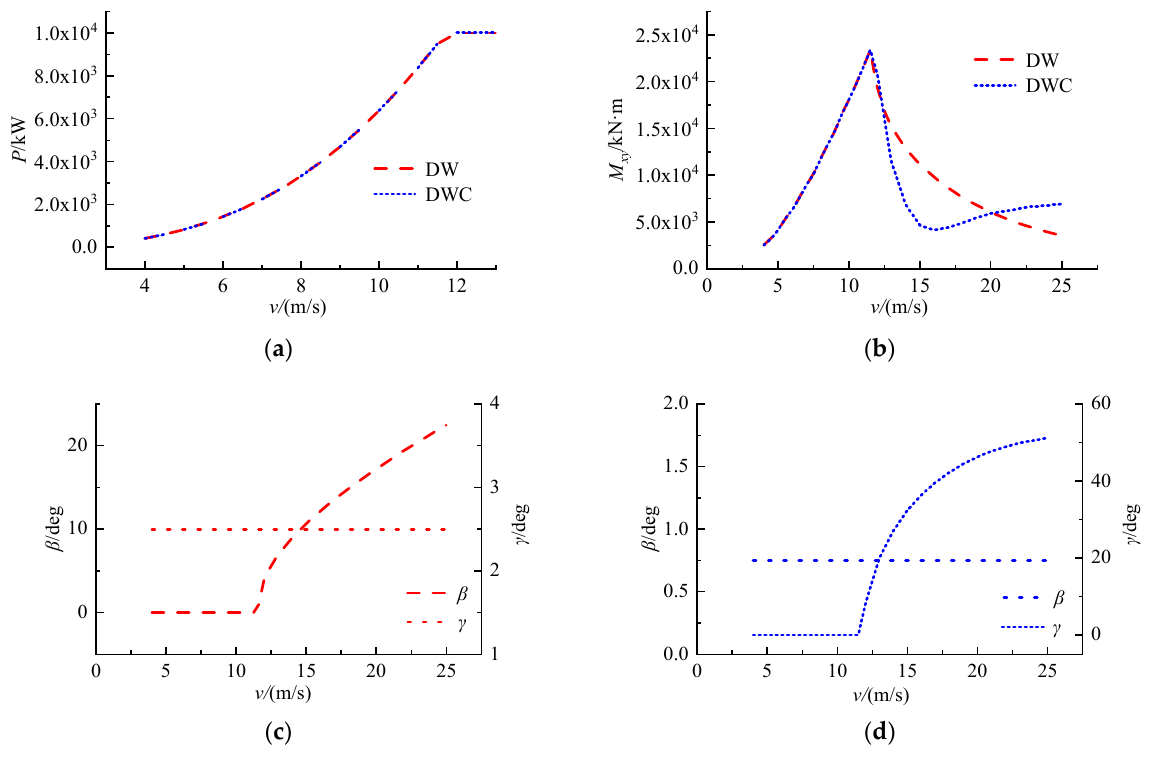
Figure 5. ( a ) Output power curves. ( b ) Loads of blade root curves. ( c ) Pitch angle and cone angle curves of DW. ( d ) Pitch angle and cone angle curves of DWC.